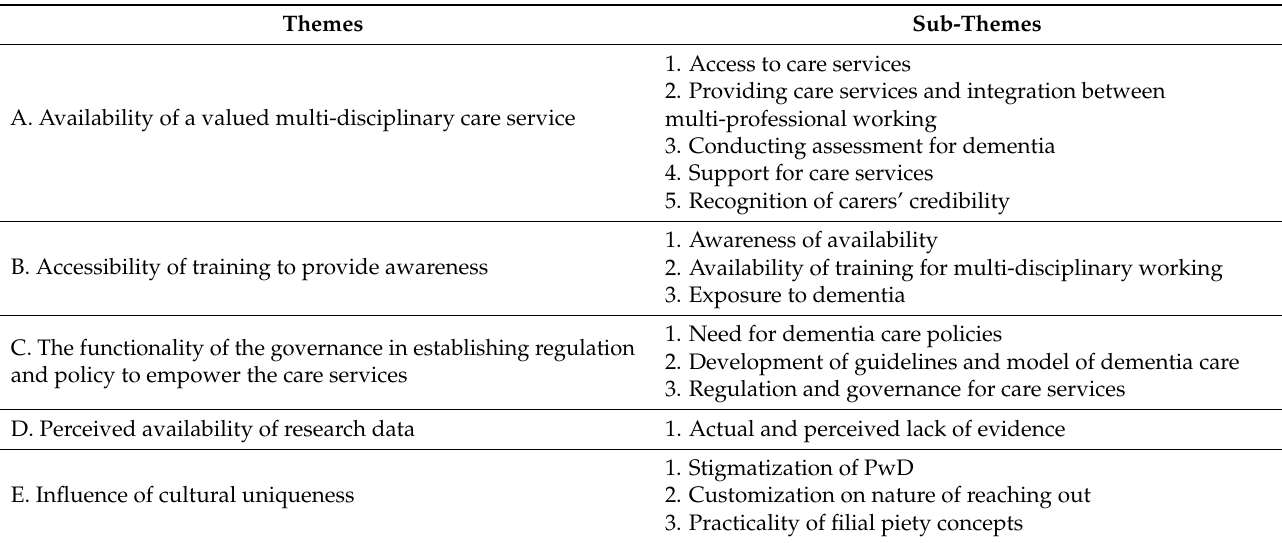
Table 2. Five themes on potential challenges for the delivery of dementia care and priorities for research and enhancing existing dementia